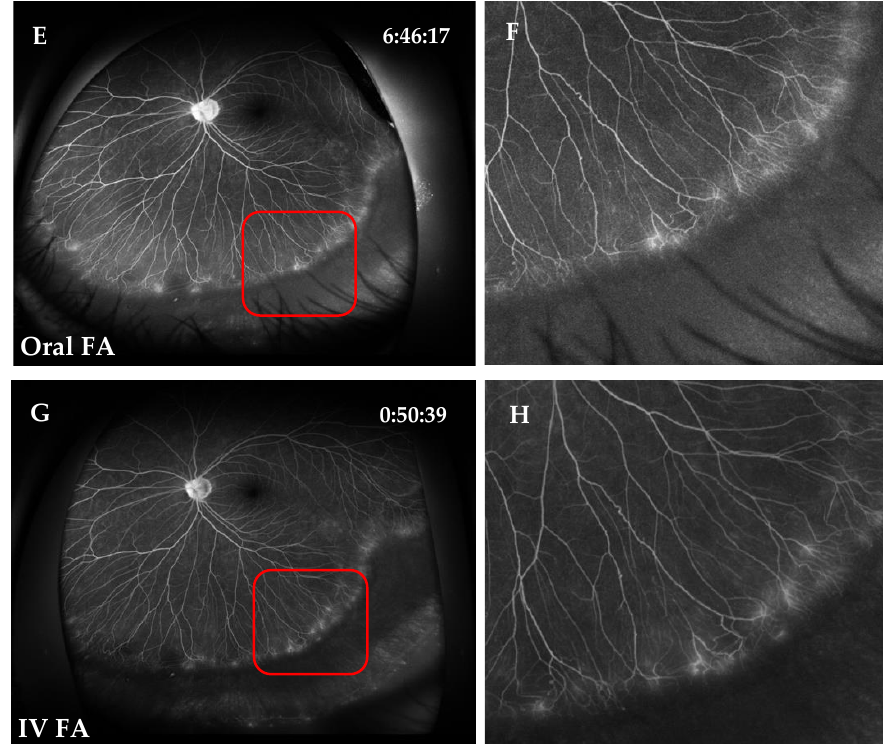
Figure 2. Representative images of the foveal avascular zone (FAZ) and non-perfusion area of Oral FA and IVFA. ( A , B ) Oral FA image of FAZ. ( C , D ) IVFA image of FAZ. ( E , F ) Oral FA image of non-perfusion area. ( G , H ) IVFA image of non-perfusion area. FA, fluorescein angiography; IVFA, intravenous fluorescein angiography.